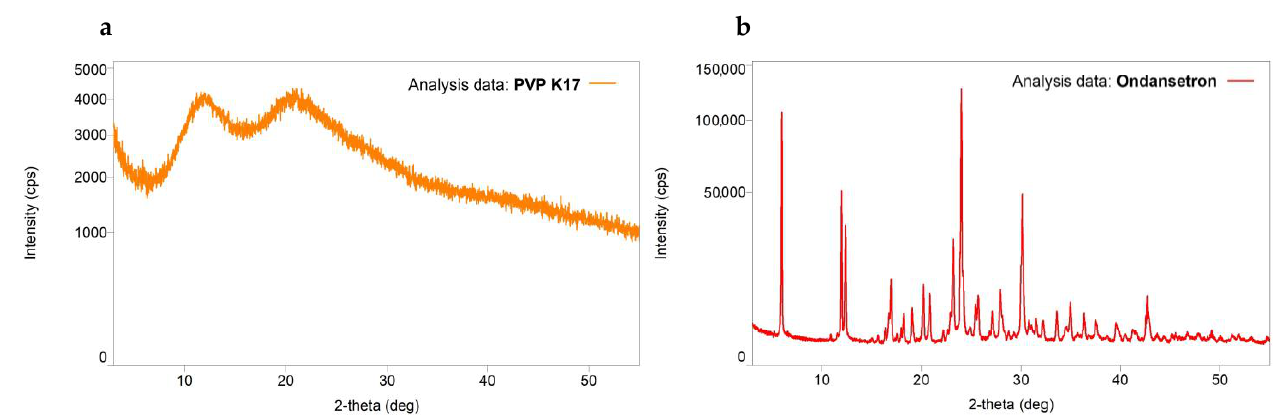
Figure 2. X-RPD diffractograms of PVP K17 ( a ) and Ondansetron ( b ).